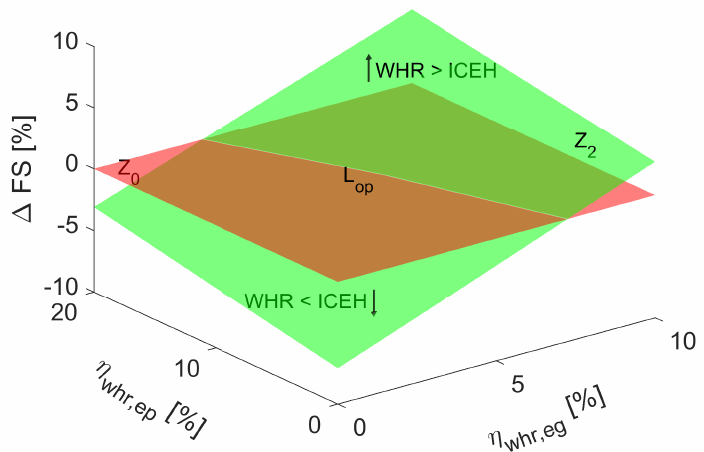
Figure 6. Relative fuel savings of the plug-in hybrid electric vehicle with different efficiencies of the dual-source waste heat recovery system on the New European Driving